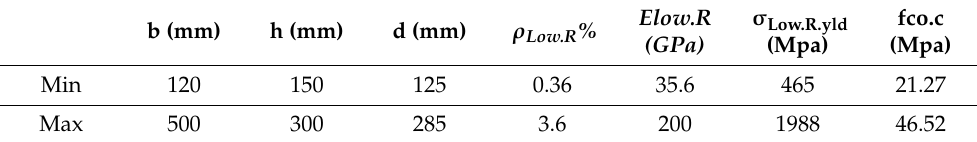
Table 1. Geometric and material variability of selected beam samples.